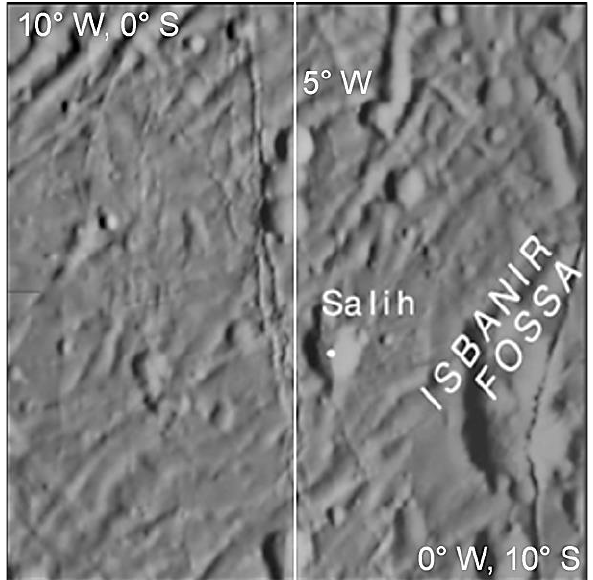
Figure 4: Crater Salih (adapted from Roatsch et al., (2008)).